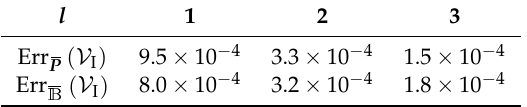
Table 3. Accuracy of RID depending on the number of neighbouring layers l for n u = 20 and n y =